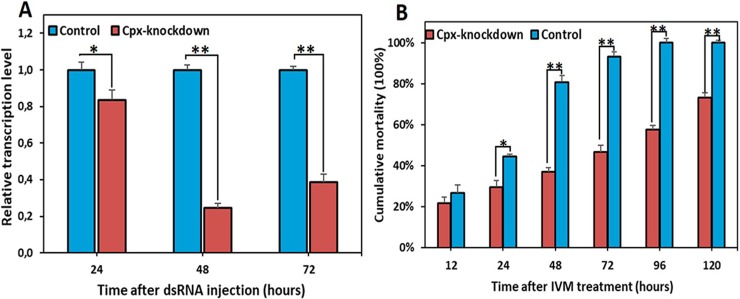
The effect of dsRNA on expression of Cpx in the IVM-susceptible strain and the effect of Cpx knockdown on IVM resistance.(A) Cpx mRNA levels were quantified by qRT-PCR in 72 hours of injection of dsRNA Cpx or pQE30 (control). The change in mRNA levels in the ds-RNA Cpx were calculated relative to controls. Values are means +SEMs (n = 3). Asterisks (*) indicate that Cpx dsRNA significantly suppresses the levels of Cpx transcript (t-test, *P<0.05 and **P<0.01). (B) Bioassays for Lab-IVS lice exposed to IVM (150 μg/Kg) started 48 hours post-injection of dsRNA Cpx or pQE30 (control). Asterisks (*) indicate that knocking down Cpx expression decreased IVM-susceptibility in the Lab-IVS strain compared to the control (Chi-2 test, *P<0.05 and **P<0.01).